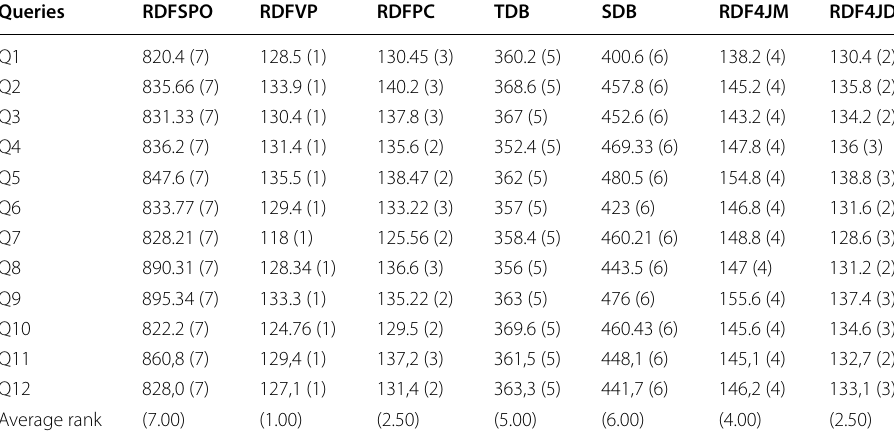
Table 6 Comparison of query response time (ms) metric of the proposed and existing methods on 12